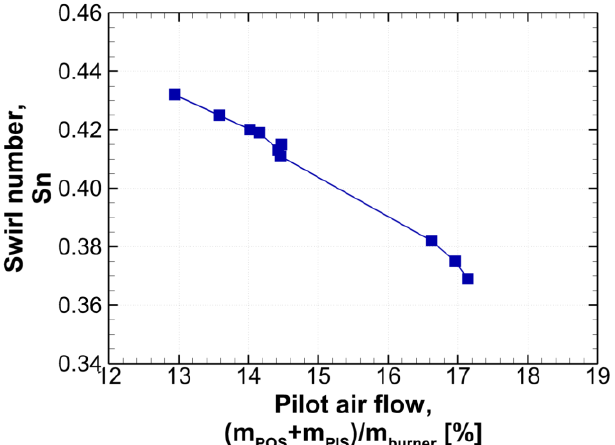
Figure 7. Relationship between burner swirl number and pilot air-flow rate. (Copyright by ASME — "Effects of Fluidic Control of Air-Flow Distribution on Staged Lean Jet Engine Burner," by Yoshida, Schneider, Hassa, Paper No: GT2016-57453).